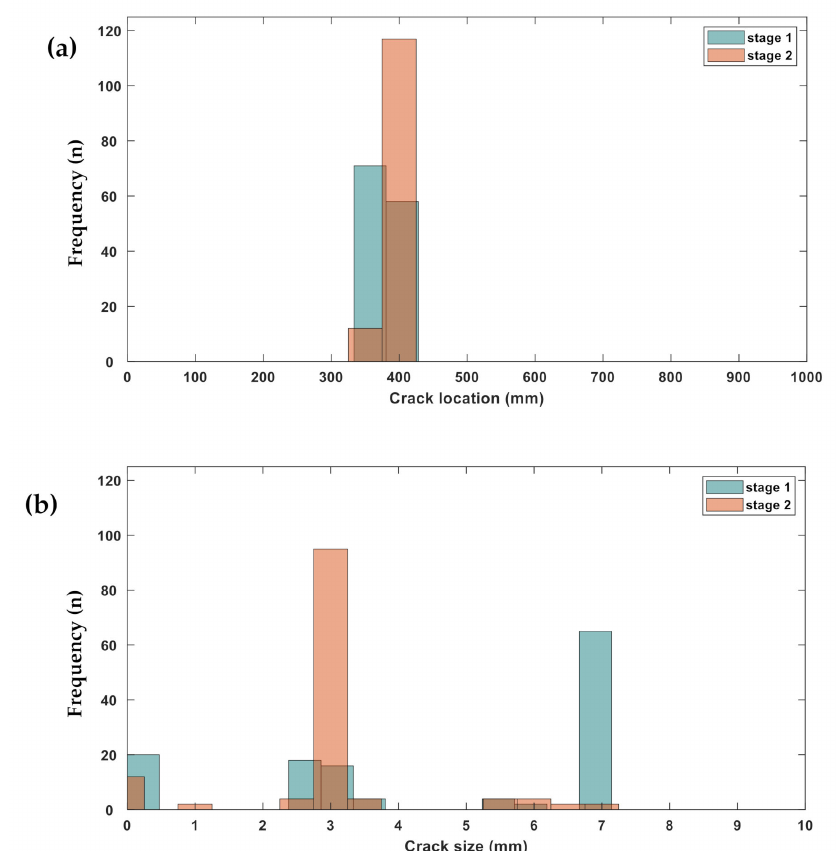
Figure 4. Frequency diagrams (probability density) of ( a ) crack location and ( b ) crack size for Case